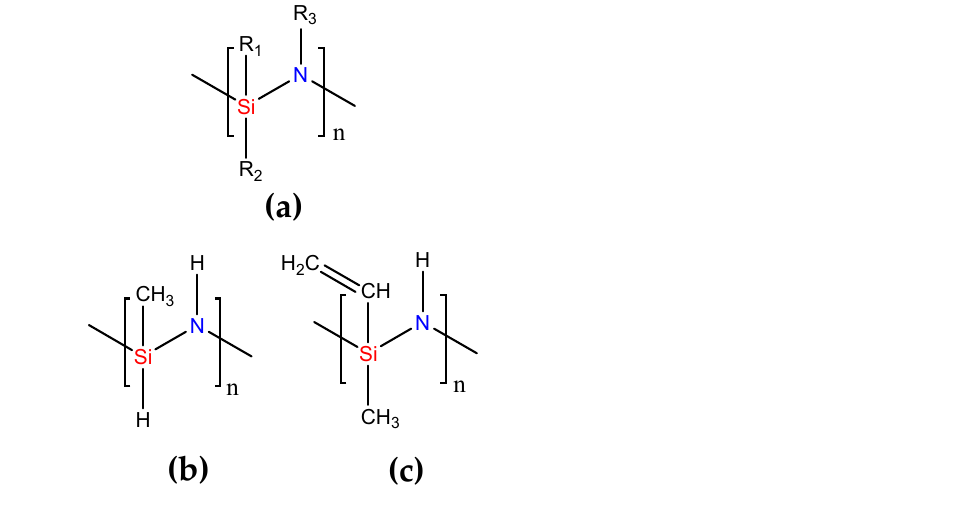
Figure 1. ( a ) Chemical structure of Durazane 1800 with R 1 , R 2 , and R 3 , which are usually H, CH 3 , or CH=CH 2 bonds, respectively, demonstrated in the chemical structures ( b , c ).